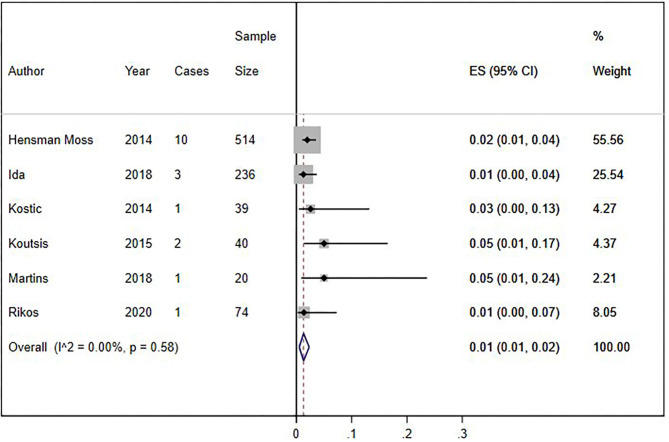
Sensitivity analysis of percentage of C9orf72 hexanucleotide repeat expansion in Huntington Disease-Like patients, without studies with zero results. Meta-analysis of six studies for prevalence of C9orf72 hexanucleotide repeat expansion in Huntington Disease-Like patients, excluding articles which report no C9orf72 hexanucleotide repeat expansion patient. ES, Estimated proportion; 95% CI, 95% Confidence interval.